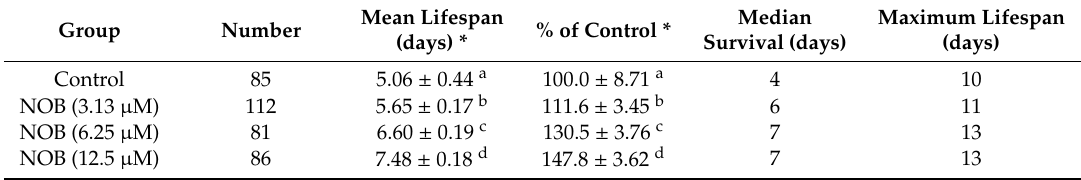
Table 4. E ff ect of NOB on paraquat-induced oxidative stress of C.